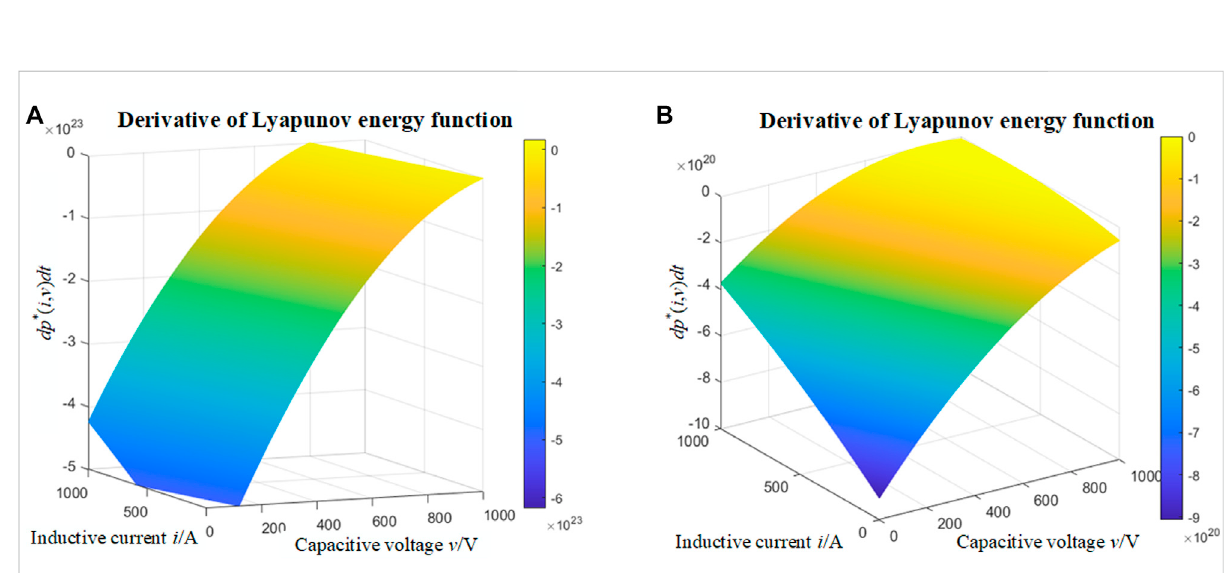
FIGURE 6 Derivative of Lyapunov energy function under PI control and VDM control. (A) dP *( i , v )/ dt under PI control. (B) dP *( i , v )/ dt under VDM